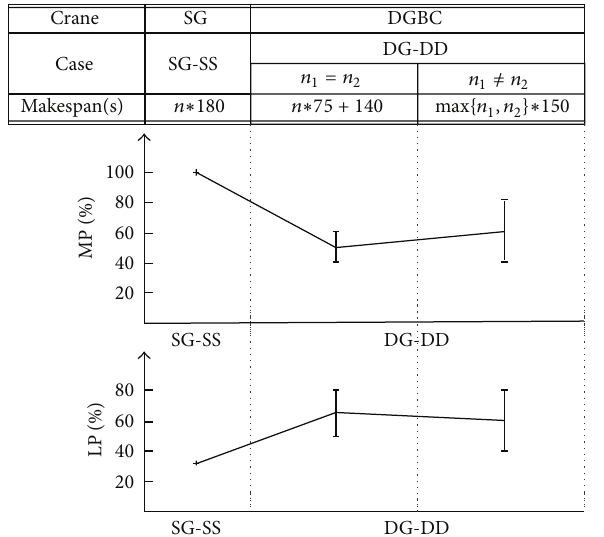
Figure 10: Comparison between SG-SS and DG-DD.